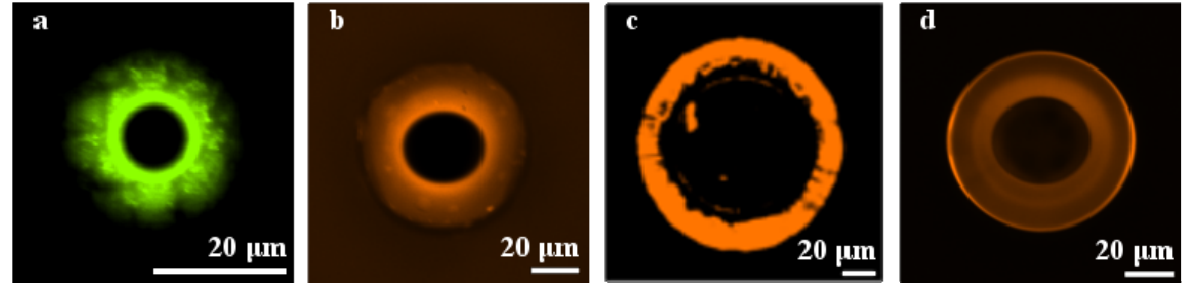
Figure 6. Fluorescent micrographs of microtoroids after labeling. (a) FITC-labeled, aminated microtoroid after piranha treatment, followed by organic solvent deposition.